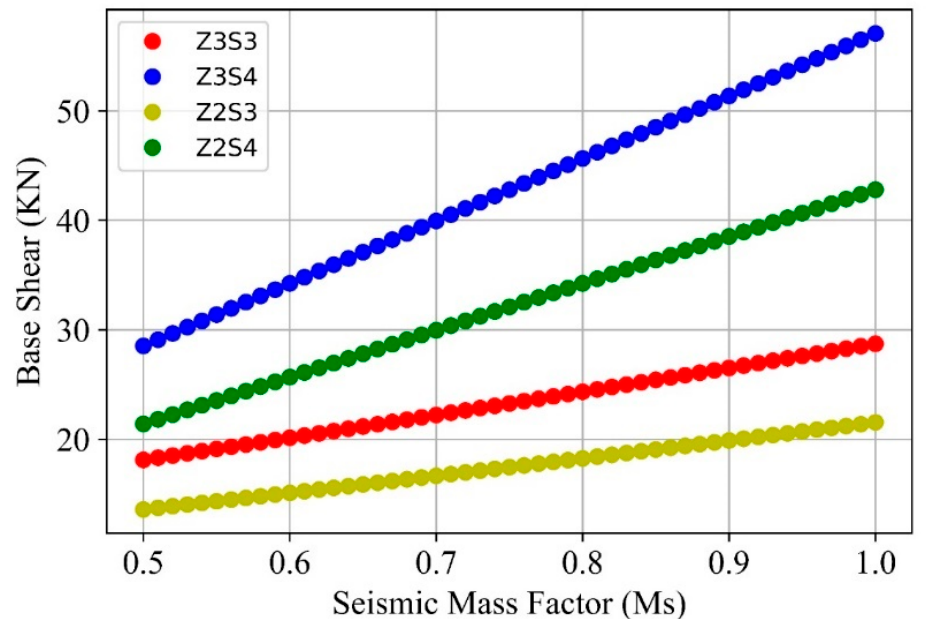
Figure 15. Variation of seismic mass factor (Ms) vs. base shear.